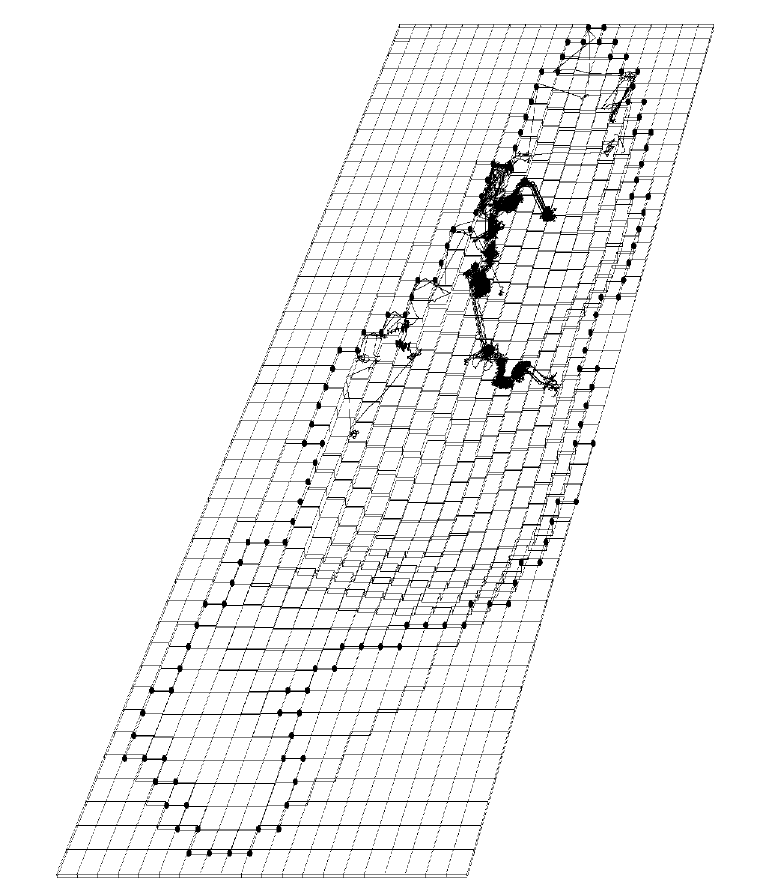
FIGURE 4. Tracks of ten roaches ( Rutilus rutilus ) in Lake Belau (Northern Germany) during a time period of 3 days. The simulation environment was derived from a GIS map. Each cell represents a 50- by 50-m surface. At night the swimming activity of the roach is reduced. The fish form loose schools if even-sized individuals are within sight range. In the model, the position is updated in 5-min